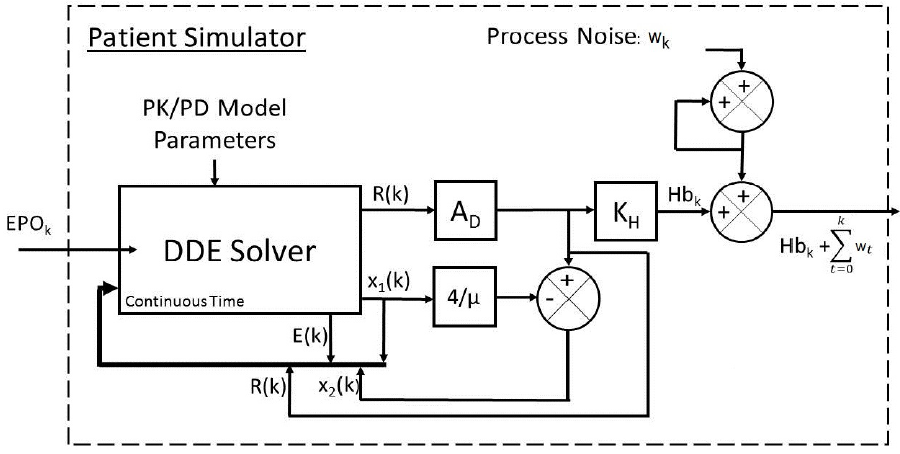
Figure 8. Block diagram of the patient